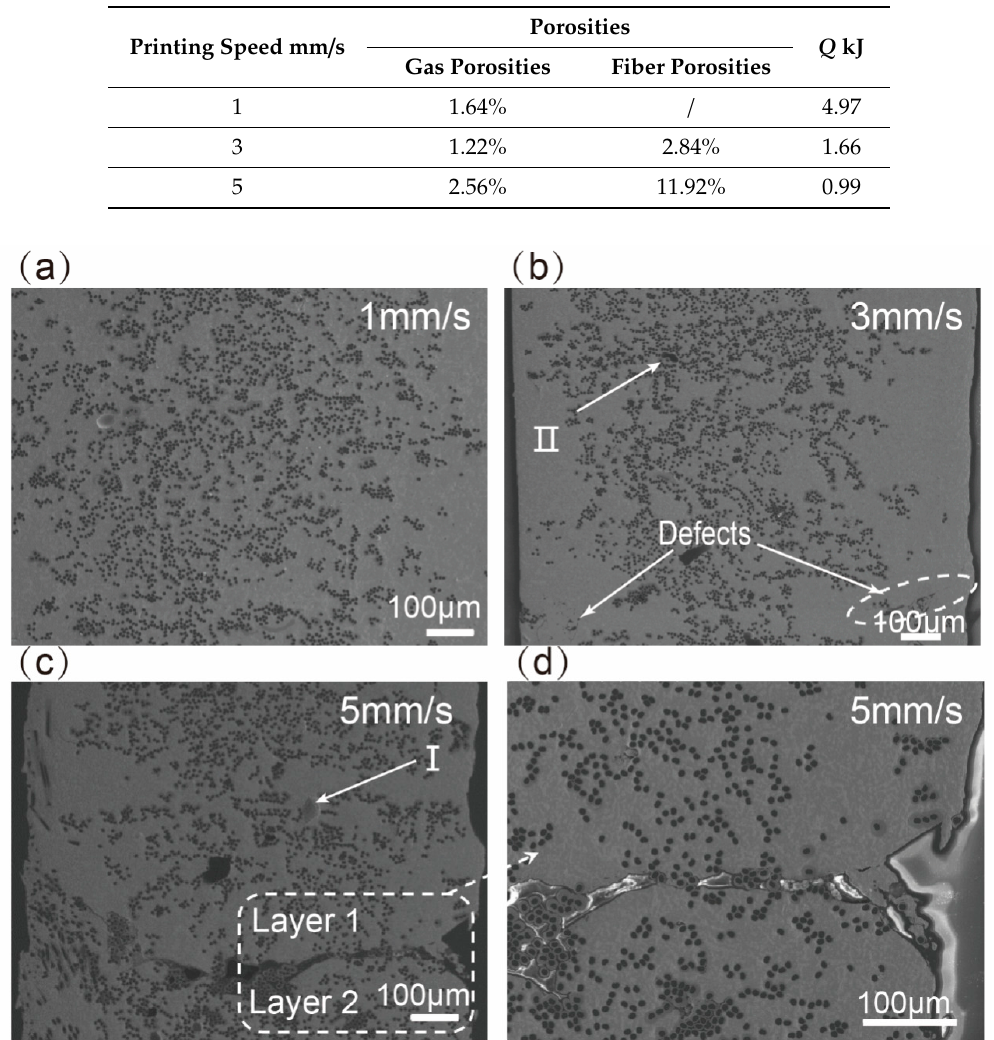
Figure 5. Images of interlayer morphology of the composite specimens ( a ) S1, ( b ) S3 and ( c ) S5 observed with back scattered electron (BSE); ( d ) Image of defect area observed in S5 with higher magnification BSE. Table 4. Porosities in composites and calculated Q.